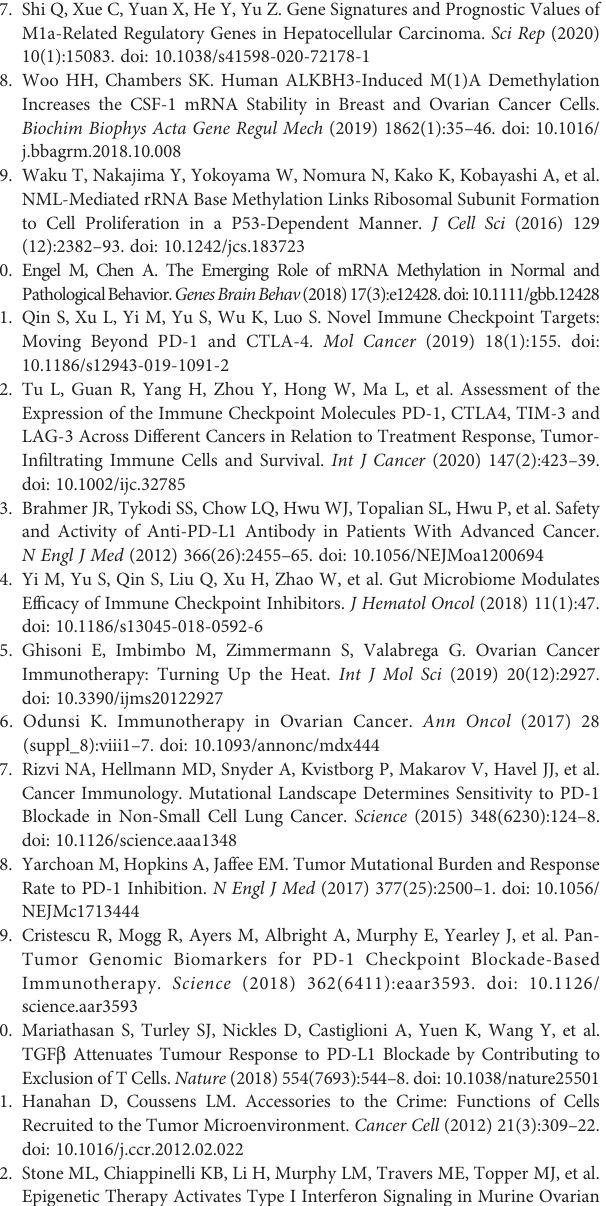
under the CDF curve for unsupervised clustering of 10 m1A regulators, k = 2-9. (C) Heat map of the consensus matrix for the OC sample at k = 3. (D) Gene Ontology (left) and Kyoto Encyclopedia of Genes and Genomes (right) enrichment analyses of 527 m1A phenotype-related DEGs. (E) Cumulative distribution function curves for unsupervised clustering of 527 m1A phenotype-related genes in OC cohort, k = 2-9. (F) Relative change in area under the CDF curve for unsupervised clustering of 527 m1A phenotype-associated genes, k = 2-9. (G) Heat map of the consensus matrix for k = 3. (H) The box plot indicated difference in immune scores, stromal scores and estimate score between low and high m1Ascore subgroup Supplementary Figure 5 | (A) Volcano plot of differentially expressed genes between high and low m1Ascore groups. (B) heatmap of differentially expressed genes between high and low m1Ascore groups. (C) Kyoto Encyclopedia of Genes and Genomes and (D) Gene Ontology enrichment analyses of differentially expressed genes between groupings of high and low